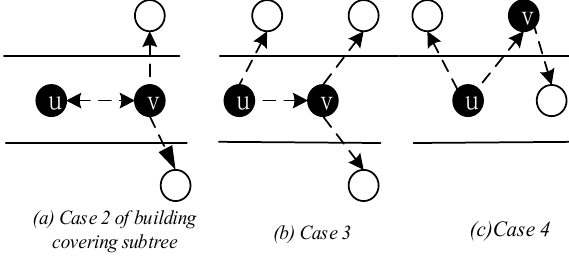
Figure 16. Building covering sub-tree.